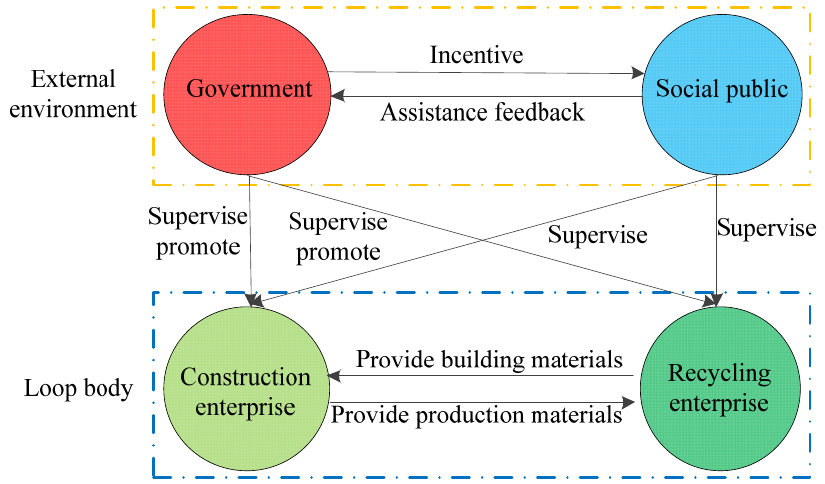
Figure 4. The relationship among